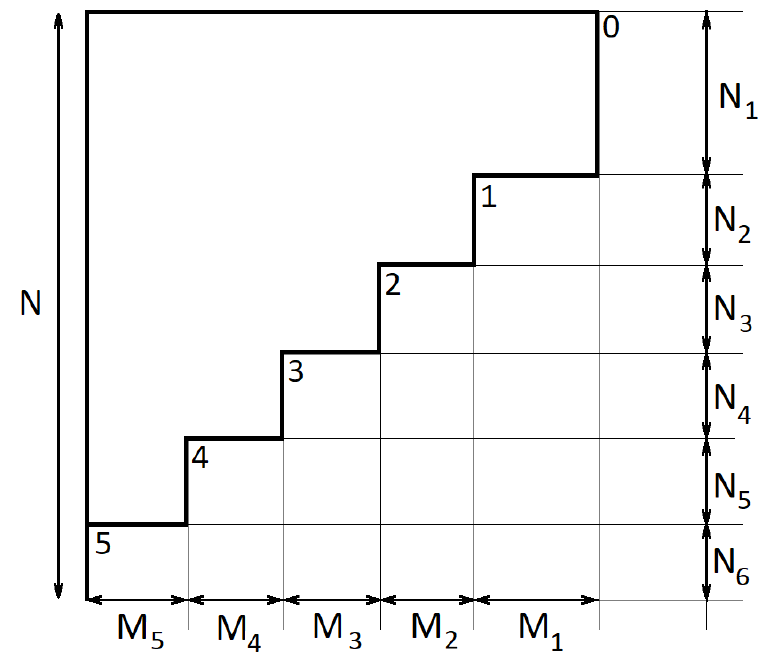
Figure 2 . A possible label B for a Schur polynomial describing an LLM background. Note that P 6 N i = N i =1